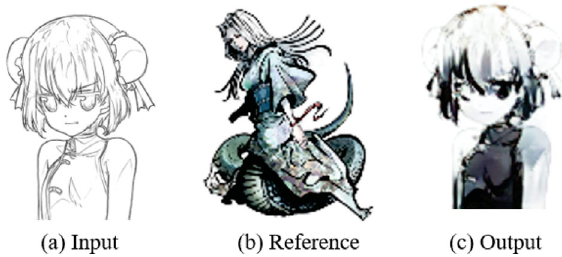
Fig. 9 Our method may not work well when the style reference contains very few color information or when the style reference and the input sketch are too different in structure